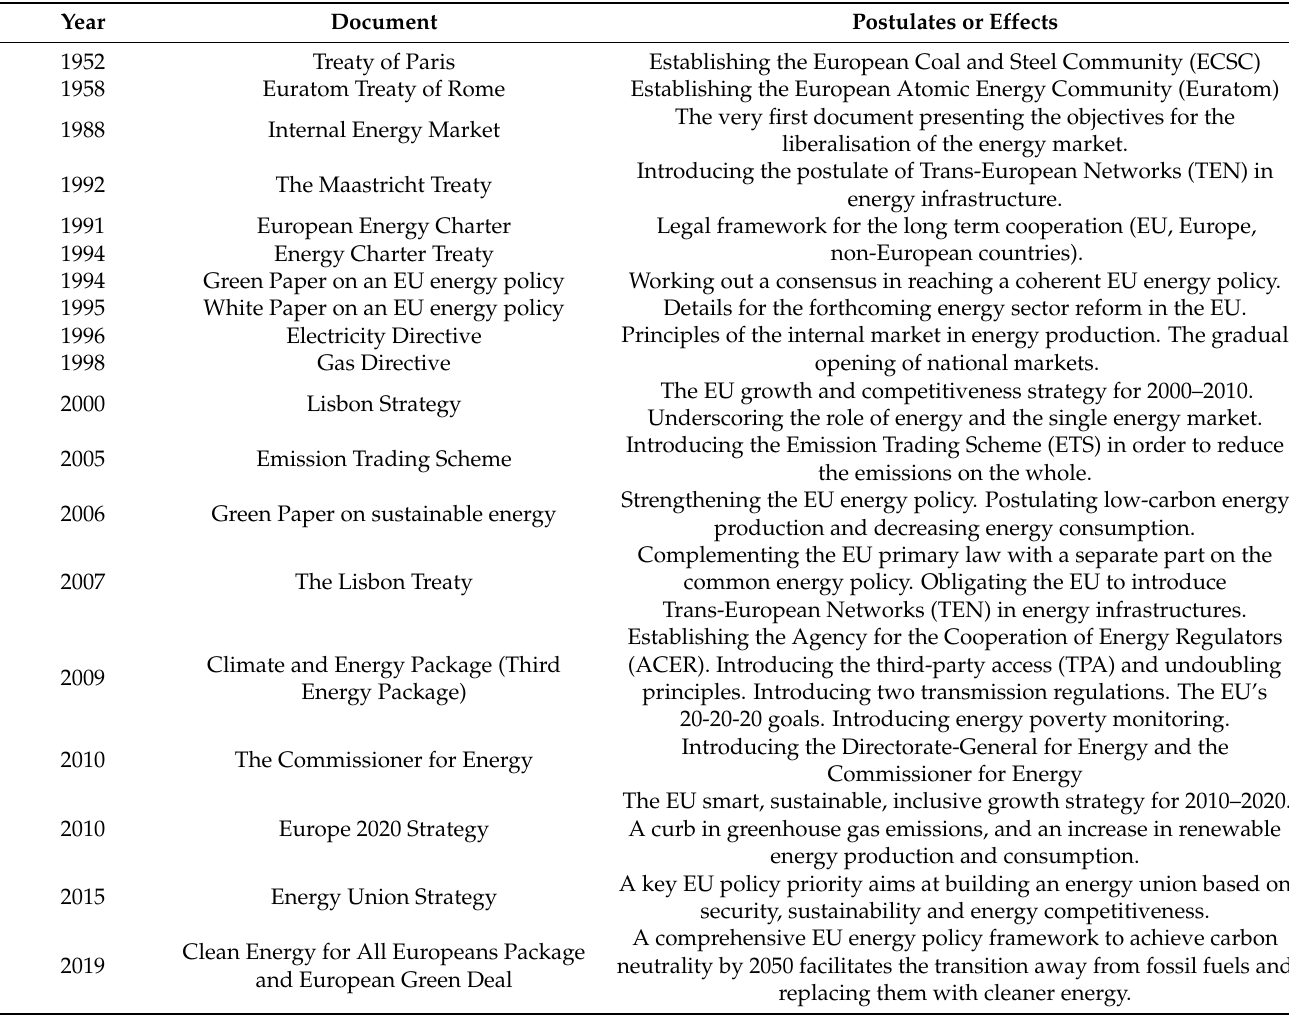
Table 1. Milestones in the development of the EU energy